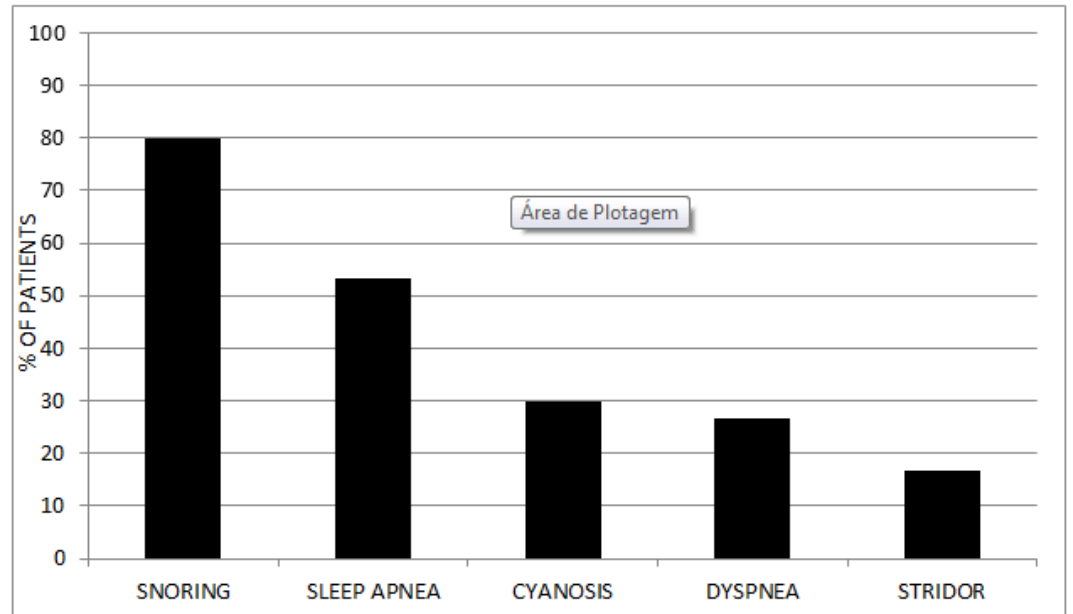
Figure 2. Percentage of clinical findings (as referred by patient history) in the mucopolysaccharidoses (MPS) patients evaluated.